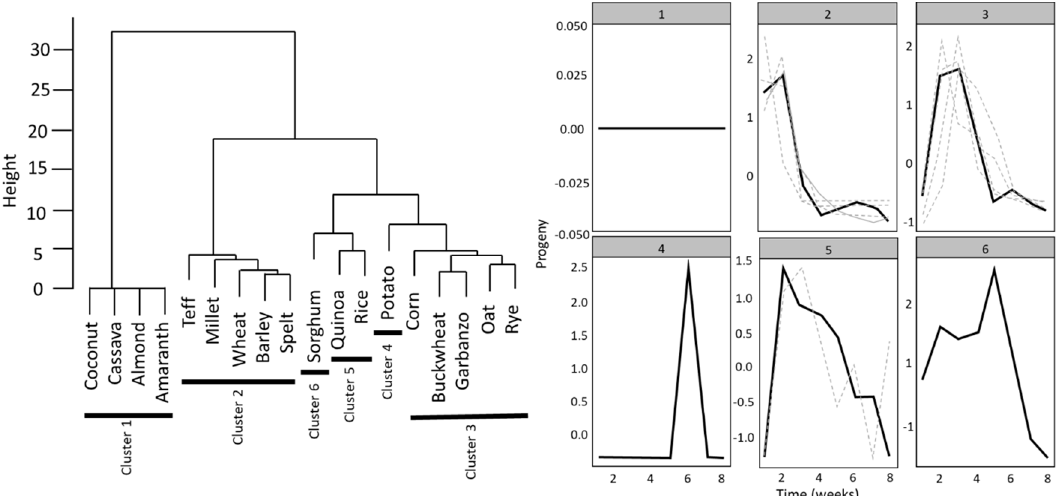
Figure 3. Dendrogram and Clustered curves for progeny emergence over time for flour. Black curves in the clusters represent the centroid of the curve fitting. Dashed curves represent any other output curves that did not fit directly on the centroid curve but have good fit in the cluster.